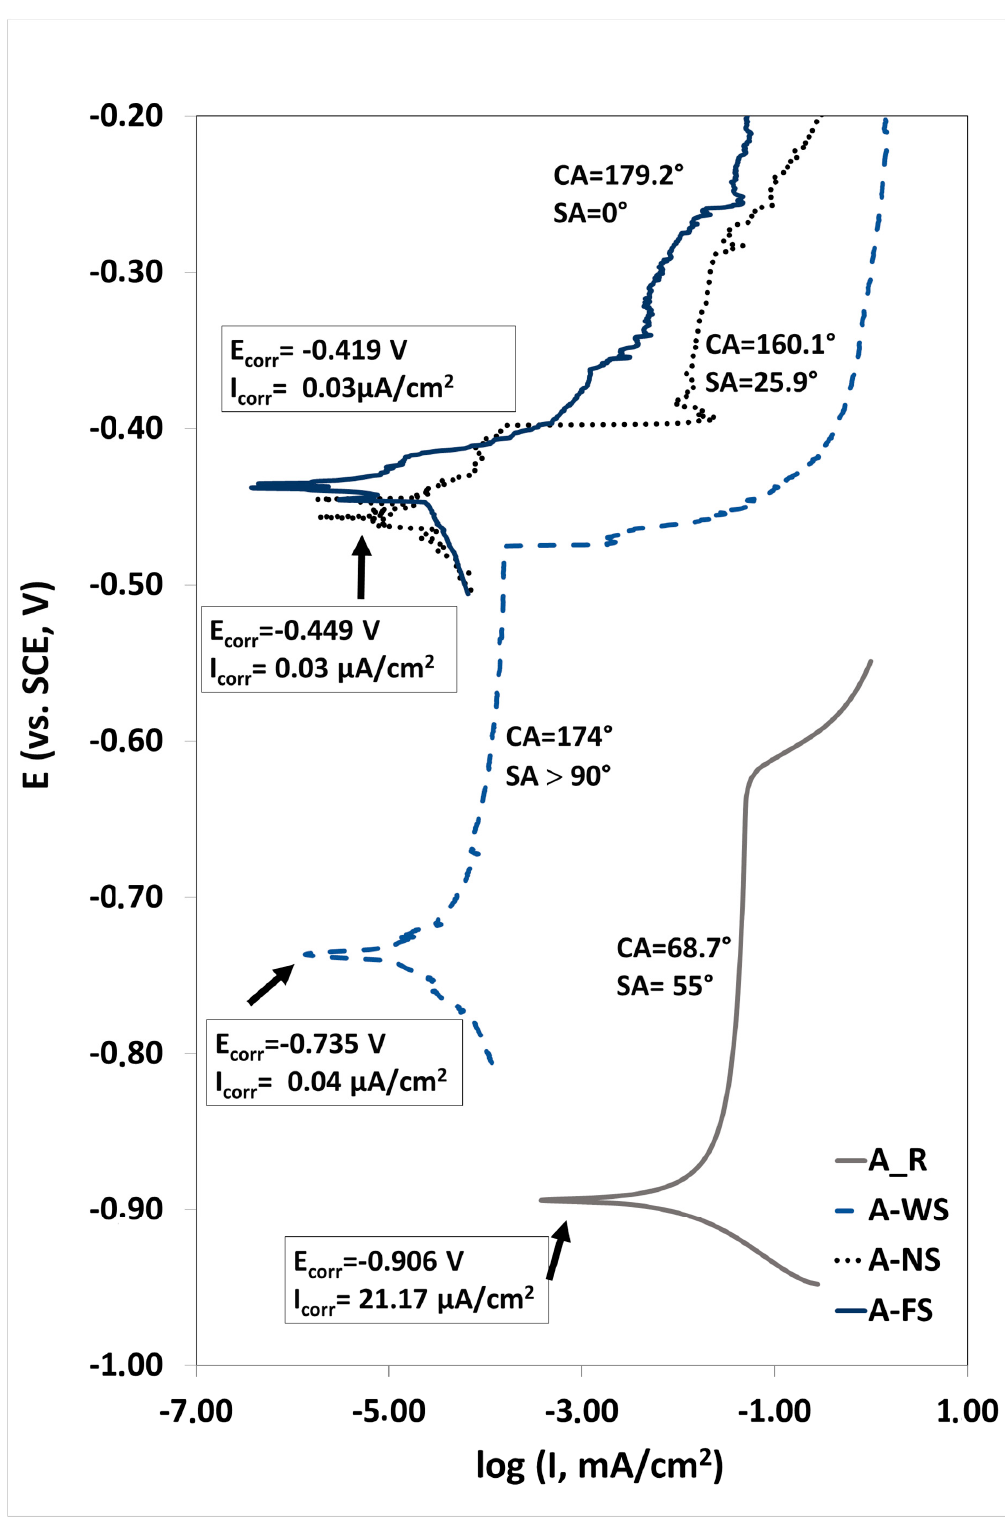
Figure 7. Polarization curves of A_R, A_WS, A_NS, and